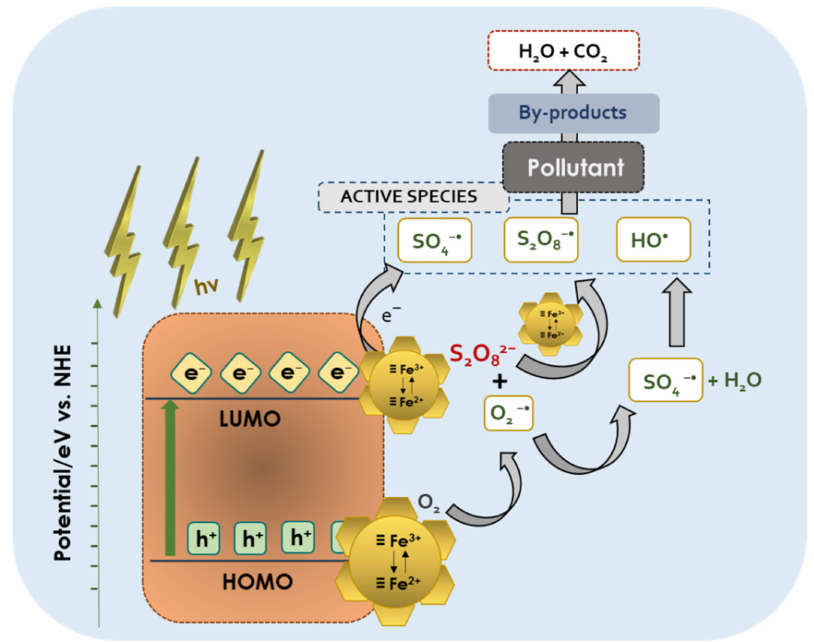
Figure 9. Schematic of the proposed mechanism of PDS activation over Fe-MOFs under UV light towards persistent pollutants